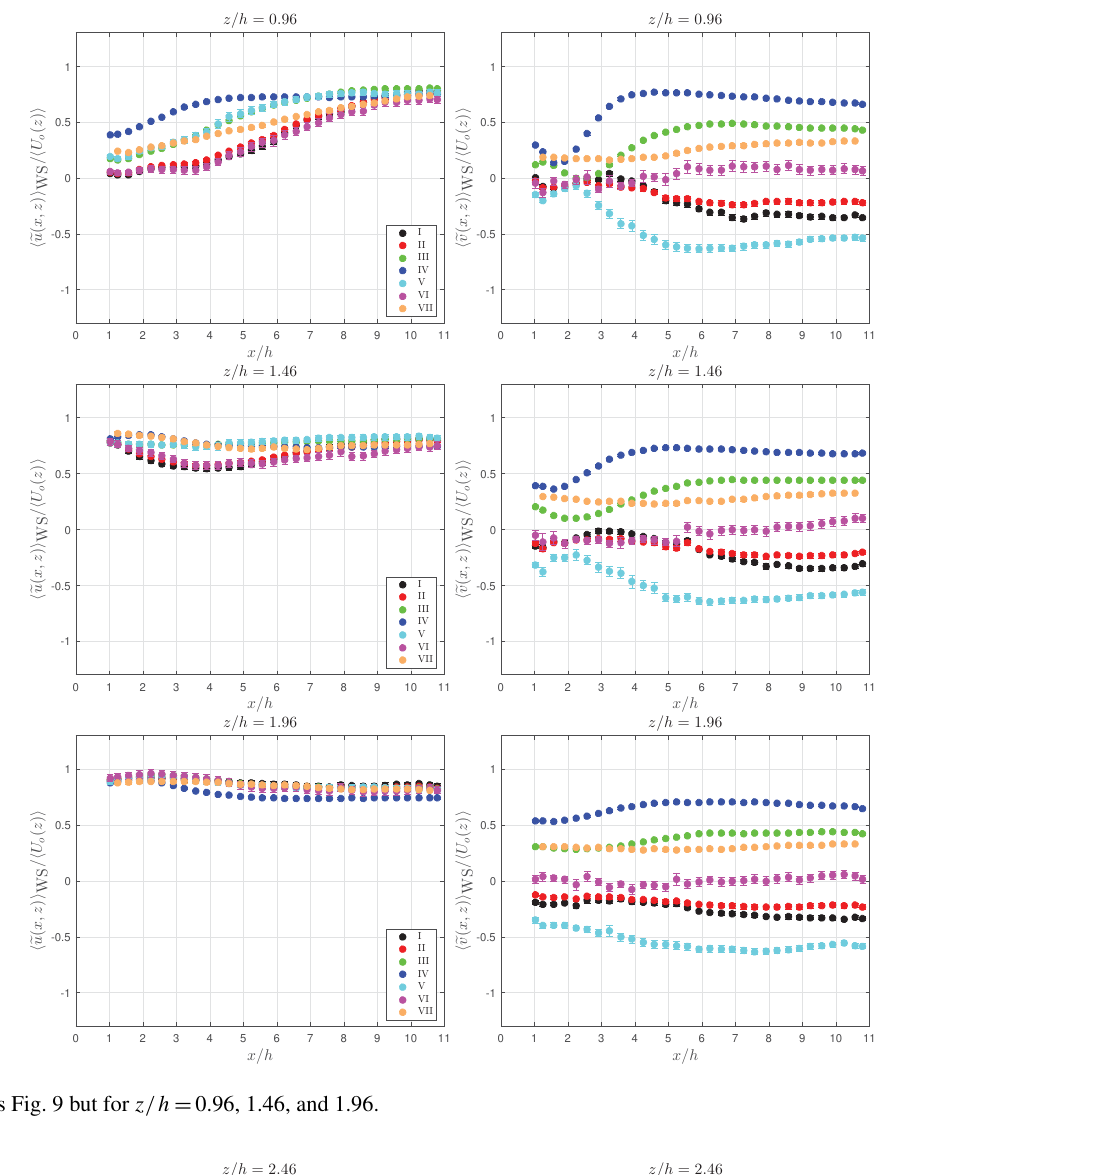
Figure 10. Same as Fig. 9 but for z/h = 0.96, 1.46, and 1.96.